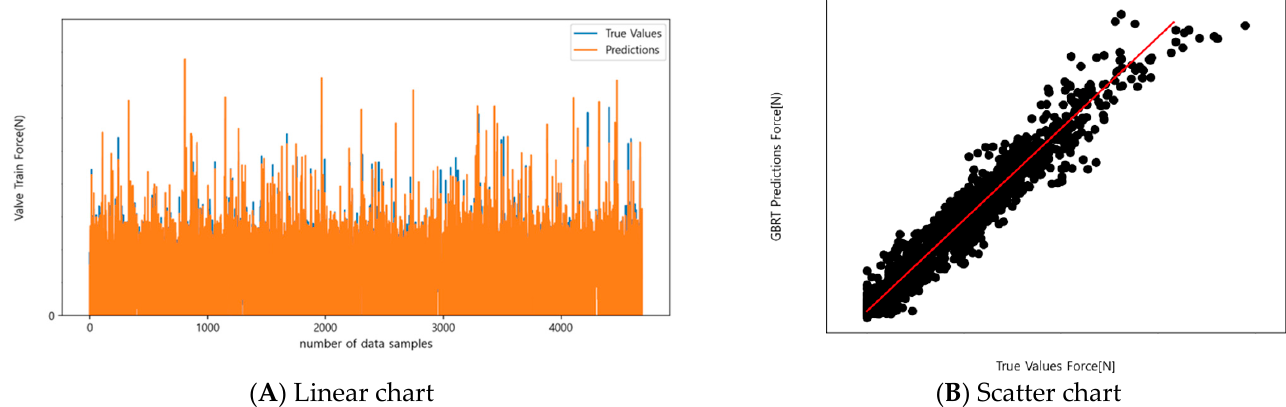
Figure 11. The predicted values of the valve train force using the GBRT model.